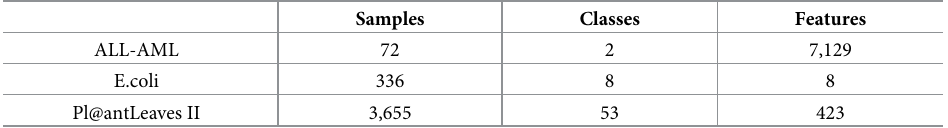
Table 1. Description of the datasets, including number of samples, classes and features.